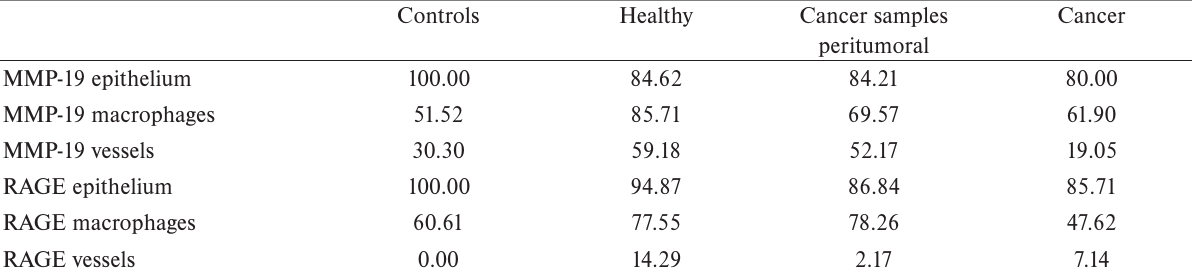
Table 1. Percentage of positive cells in samples.